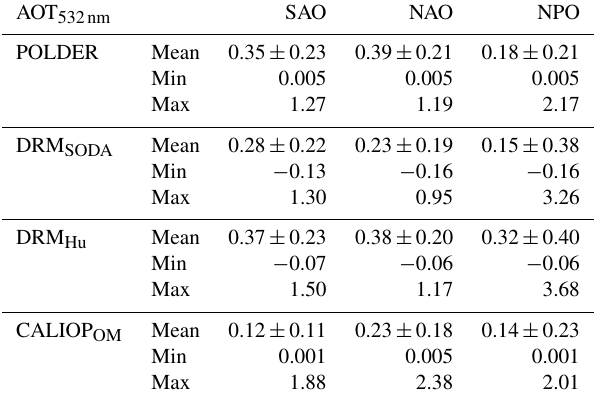
Table 4. Calculated mean, minimum value and maximum value of AOT 532nm over 6 months in 2008, for three regions (SAO, NAO, NPO) and for different